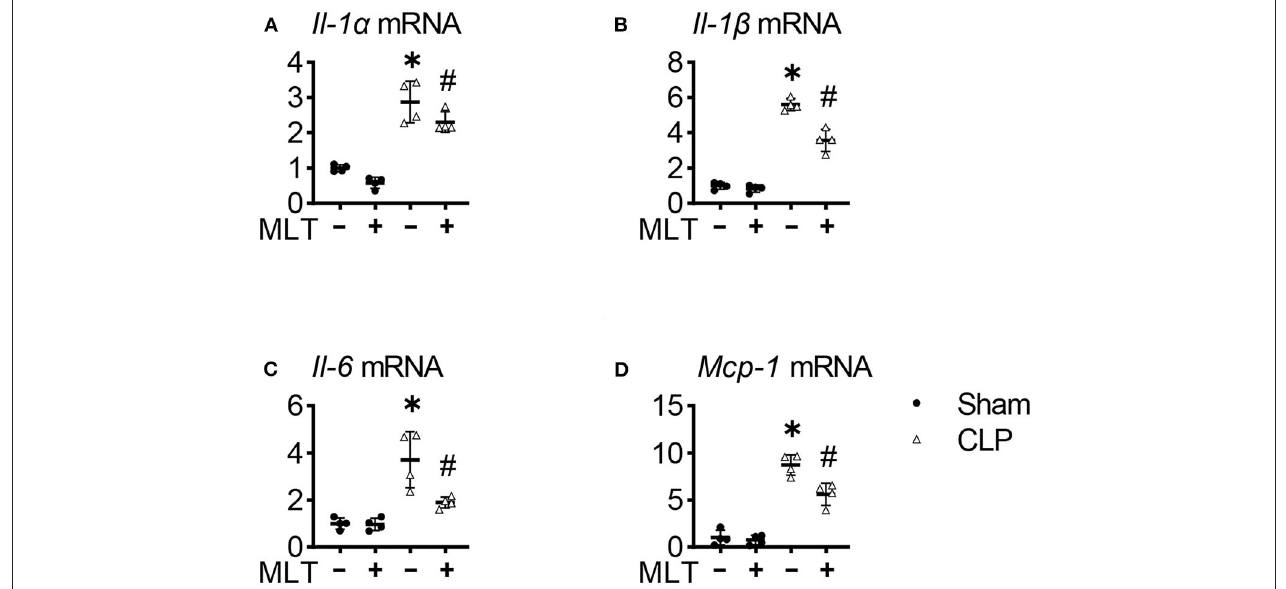
FIGURE 2 | Melatonin relieves cardiac inflammation in sepsis-induced mice. The heart tissue inflammatory cytokines Il-1 α (A) , Il-1 β (B) , Il-6 (C) , and Mcp-1 (D) mRNA levels were measured using real-time quantitative PCR (RT-qPCR). Values are presented as means ± SD, *vs. sham, p < 0.05; # vs. CLP, p <